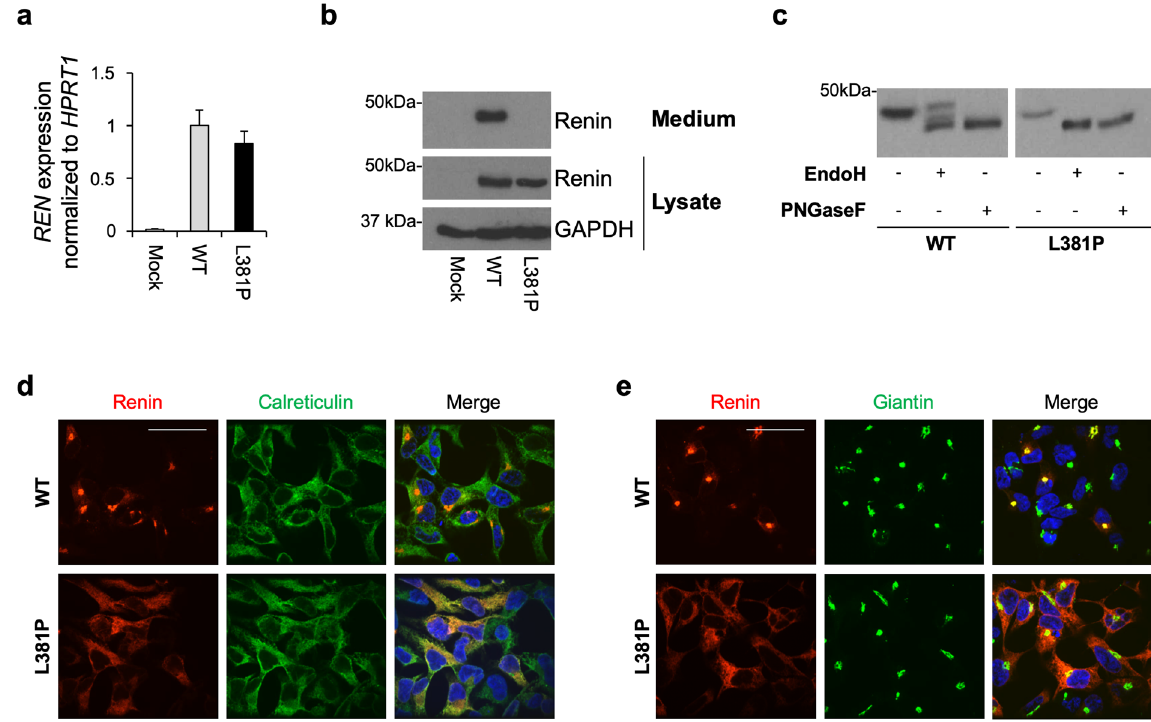
Figure 2. The L381P renin isoform is retained in the ER. ( a ) Renin expression in stably transfected HEK cells assessed by real-time RT-qPCR. Expression is normalized to HPRT1 . Data are expressed as mean ± s.d. (n = 3 independent experiments). (b) Western blot analysis showing renin expression in cell lysate and conditioned medium. GAPDH is shown as a loading control. No secreted renin can be detected for the L381P isoform. (c) Western blot analysis showing renin in HEK lysates after treatment with EndoH or PNGaseF. Full-length blots ( b,c ) are presented in Supplementary Fig. S1. (d) Immunofluorescence analysis showing renin (red) and calreticulin (ER marker, green) and merged pictures with nuclei (dapi, blue). Bar = 40 μ m. The variant L381P shows co- localization with calreticulin demonstrating its ER retention. (e) Immunofluorescence analysis showing renin (red) and giantin (Golgi marker, green) and merged pictures with nuclei (dapi, blue). Bar = 40 μ m. Co-localization with giantin is seen for the wild type isoform only, demonstrating its trafficking along the secretory